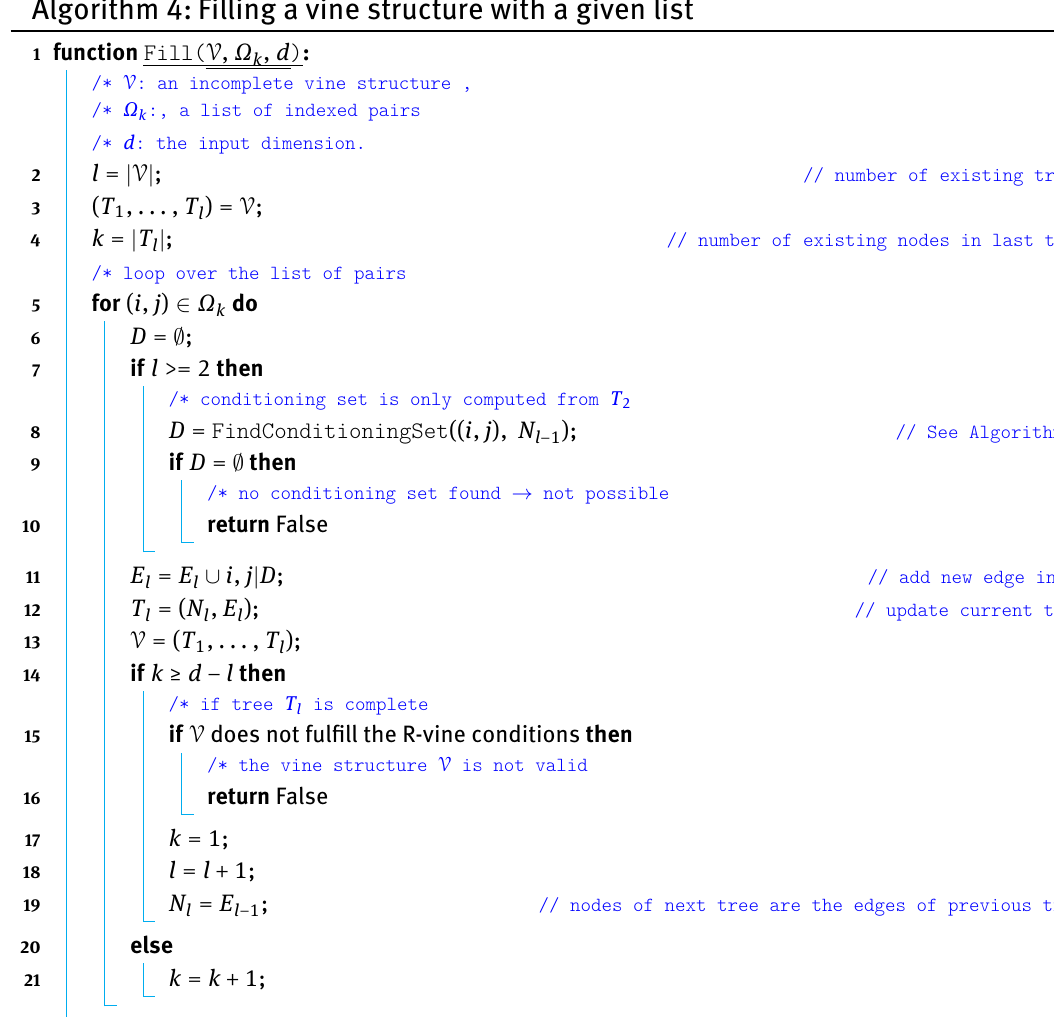
Algorithm 4: Filling a vine structure with a given